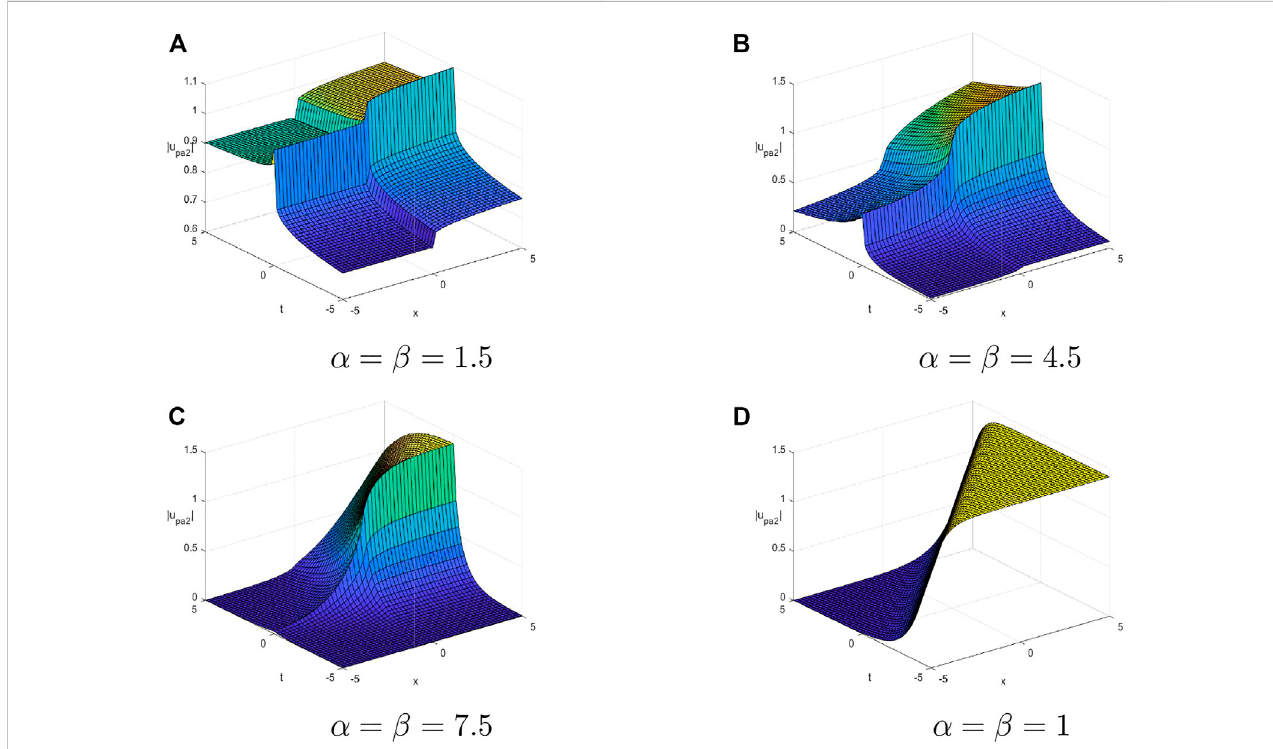
FIGURE 4 3Dplots ofdark soliton solutionsfor theparabolic law non-linearity with thefourdifferentfractional values byconsidering thevalues A 1 =1, B = − 1, v =1, κ = − 1, ω = 3, and δ = 1. (A) α = β = 1.5. (B) α = β = 4.5. (C) α = β = 7.5. (D) α = β = 1.